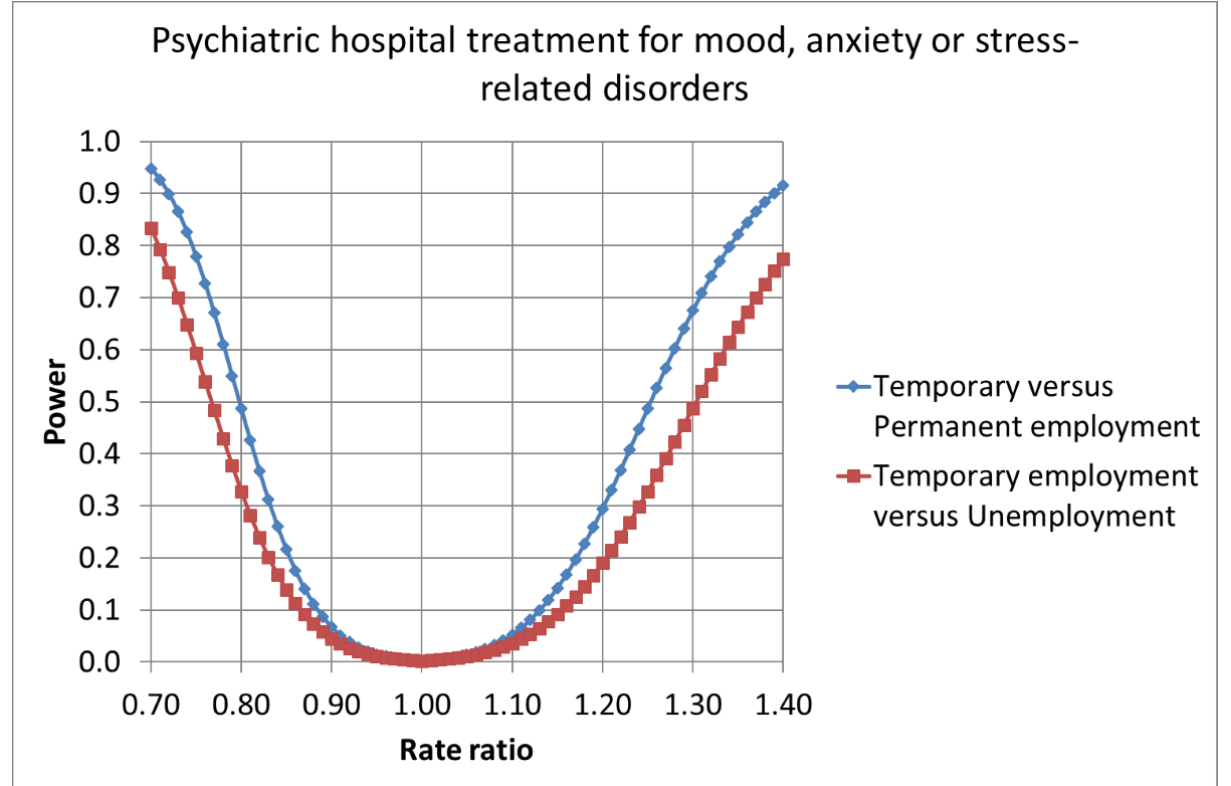
Figure 2. Power to detect main effects of fixed-term contracts on the rates of new cases of psychiatric hospital treatment for mood, anxiety, or stress-related disorders, as a function of underlying rate ratios ( α